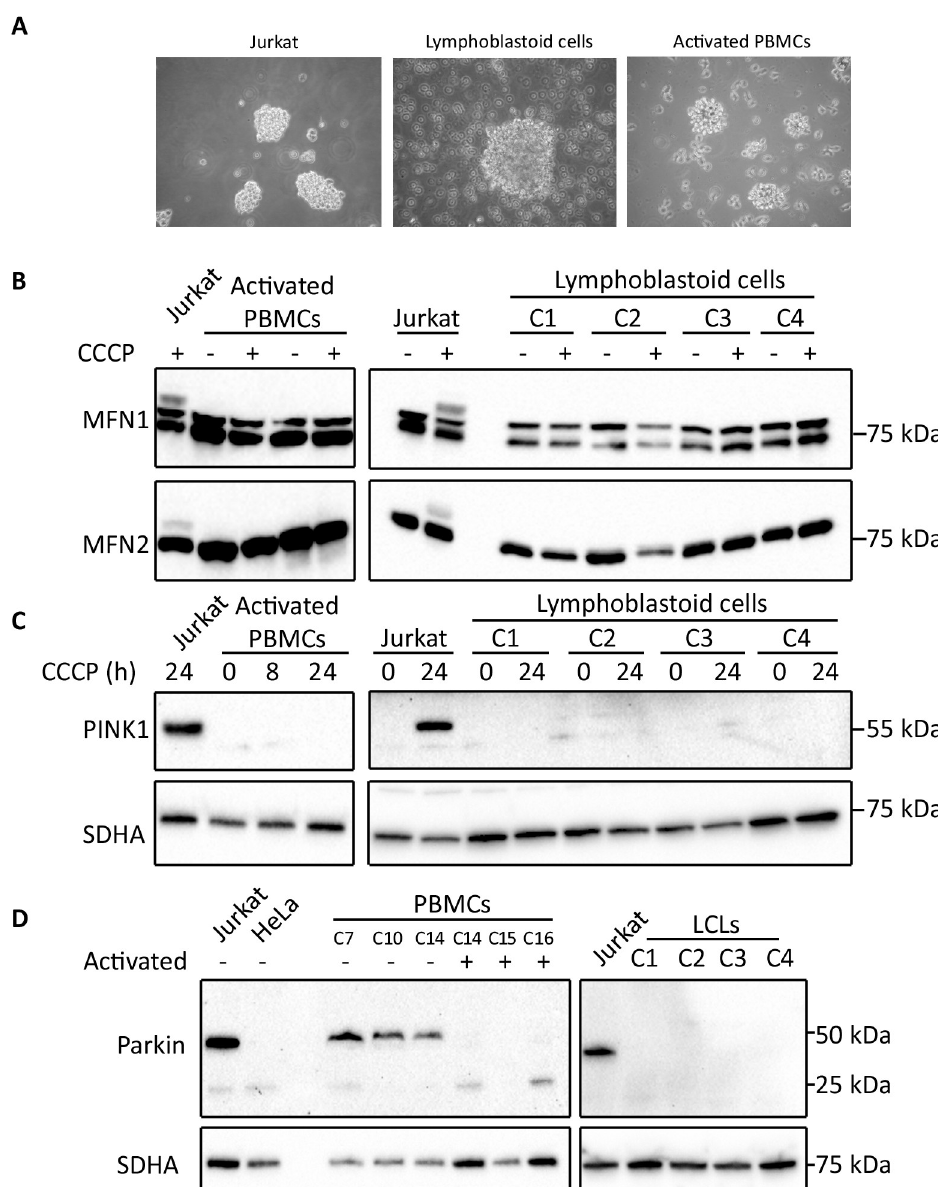
Fig 8. Analysis of PINK1 –Parkin signalling pathway in lymphoblastoid cell lines and CD3/CD28 activated PBMCs. (A) Phase contrast microscopy images of Jurkat cells, a lymphoblastoid cell line (LCL) and CD3/CD28 Dynabead-activated PBMCs. (B) Western blot analysis of MFN1 and -2 ubiquitination following CCCP treatment of activated PBMCs and LCLs. (C) Western blot analysis of PINK1 expression in activated PBMCs and LCLs following prolonged CCCP treatment. (D) Western blot analysis of Parkin expression in resting and CD3/CD28 Dynabead- activated PBMCs, and LCLs.